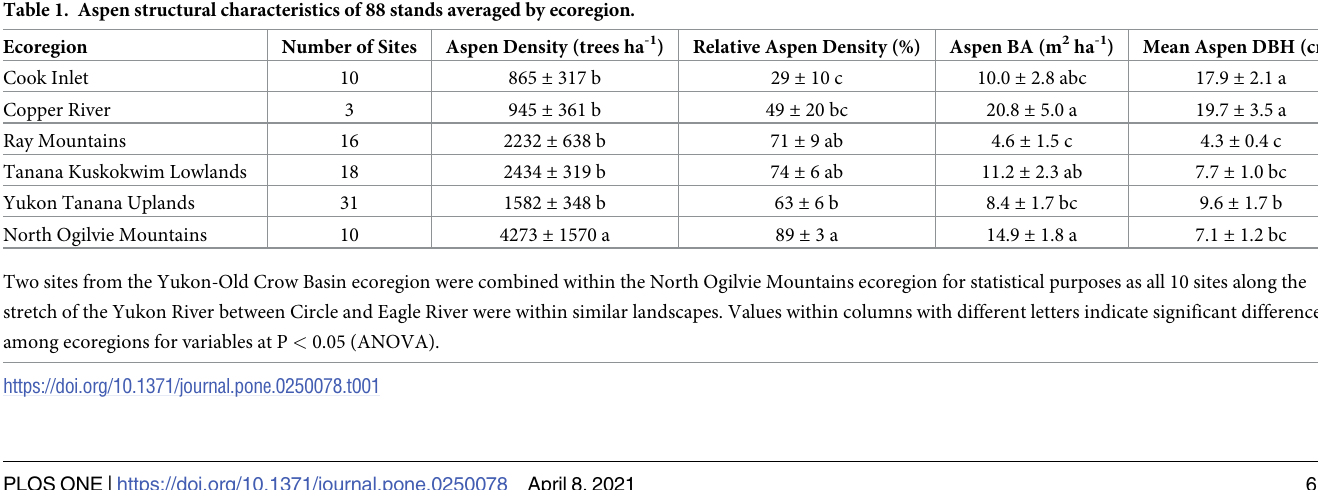
Table 1. Aspen structural characteristics of 88 stands averaged by ecoregion. Ecoregion